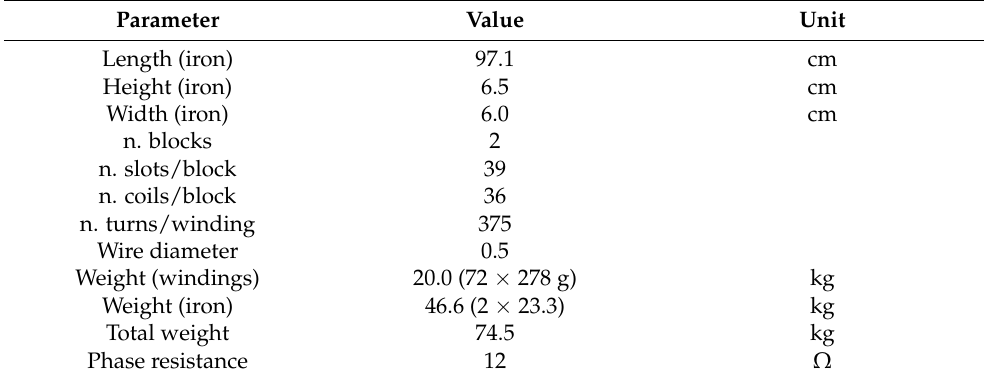
Table 1. Specific of the iron stator.